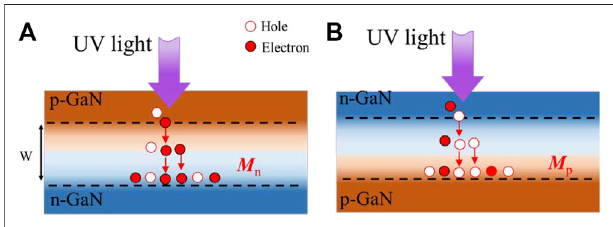
FIGURE 7 | The schematic illustration of the (A) electron- and (B) hole- initiated impact ionization multiplication in GaN p-n